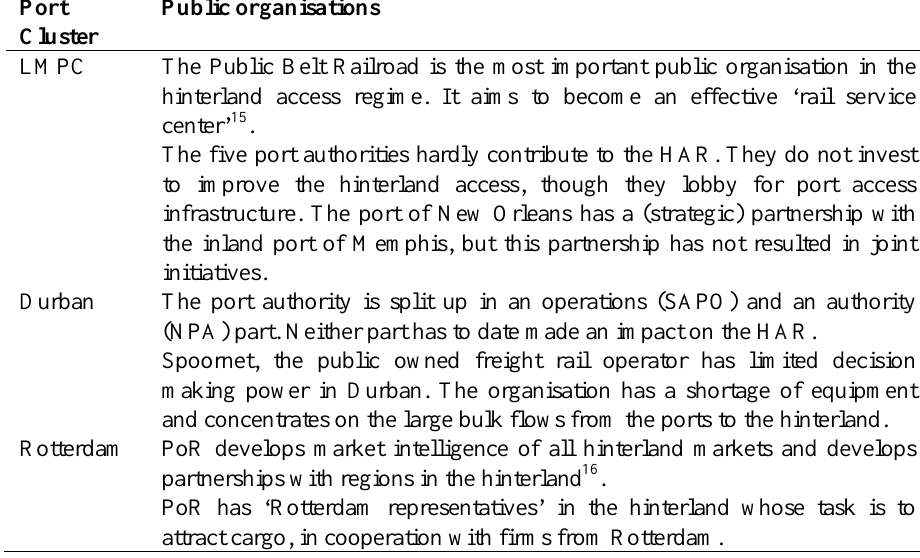
Table 12.The roles of public organisations in the HAR’s